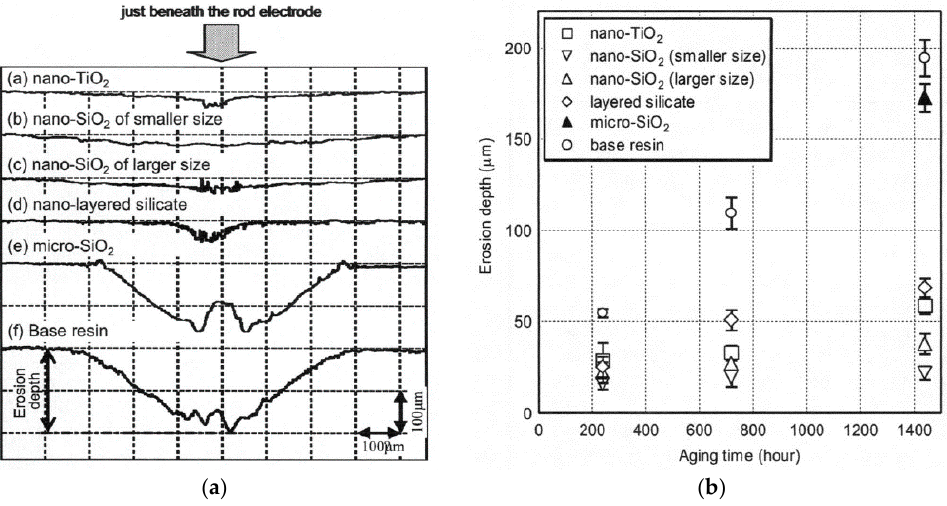
Figure 27. ( a ) Surface profiles of erodated areas due to PDs in the samples containing different